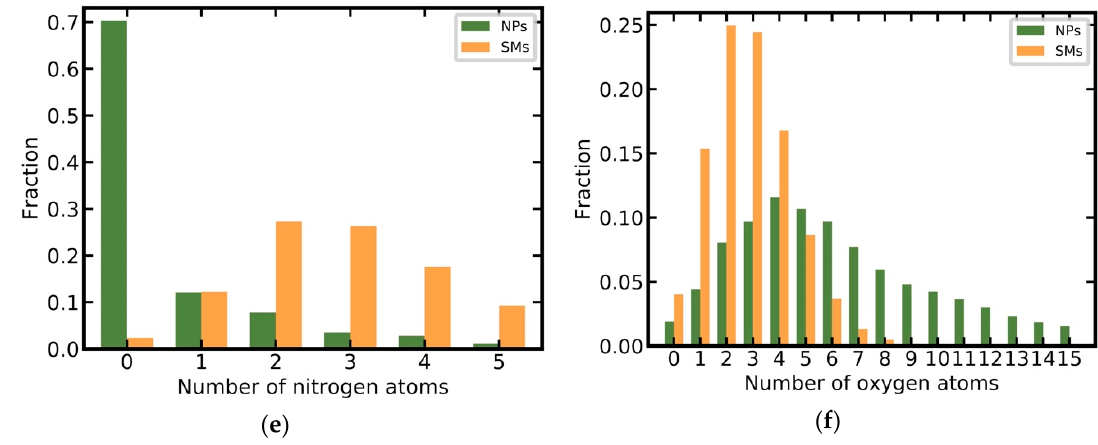
Figure 2. Distributions of key physicochemical properties among NPs and SMs: ( a ) Molecular weight; ( b ) log P (o/w); ( c ) entropy of the element distribution in molecules; ( d ) number of chiral centers; ( e ) number of nitrogen atoms; ( f ) number of oxygen atoms.